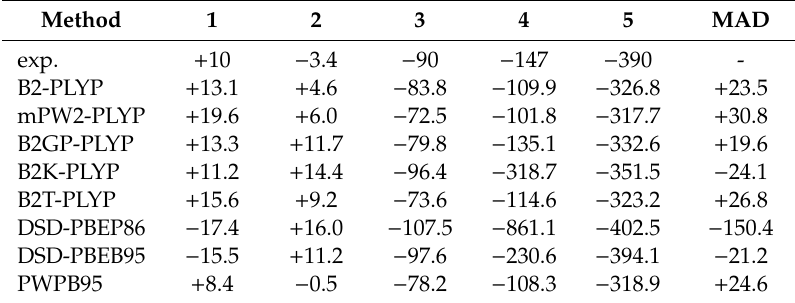
Table 3. Exchange coupling constants J (in cm − 1 ) computed with selected double-hybrid density functionals for the five manganese complexes studied in this work, compared with experimentally fitted values. Mean absolute deviations (MAD) in cm − 1